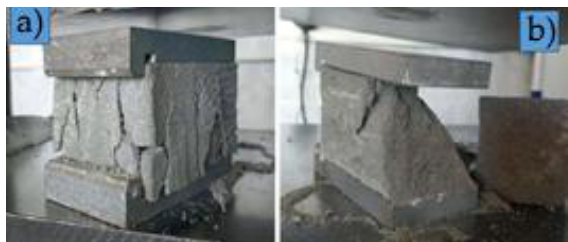
Figure 7. Determination of the compressive strength of printed halves specimens with loading: ( a ) along horizontal layers; and ( b ) perpendicular to horizontal layers.